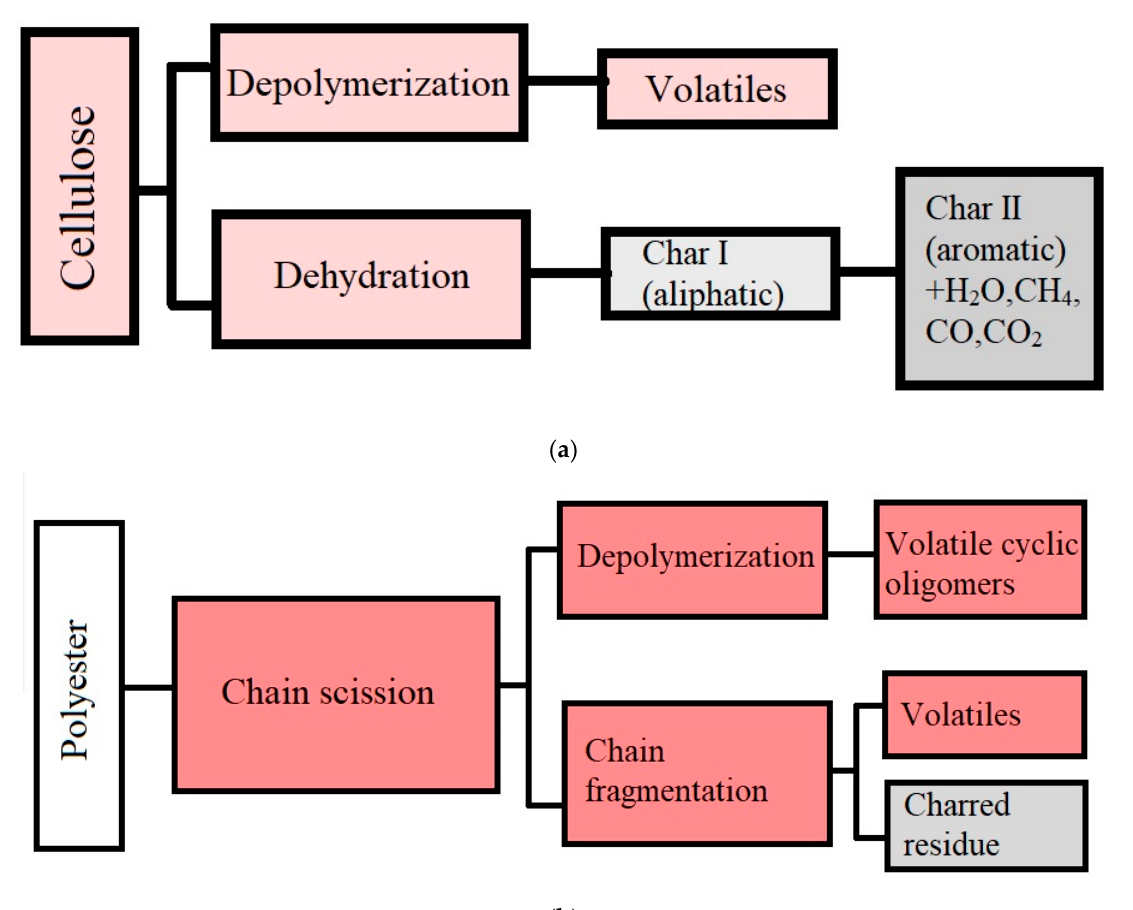
Figure 12. Mechanisms of cellulose ( a ) and polyester ( b ) degradation during thermal decomposition, adapted with permission from Ref. [108].